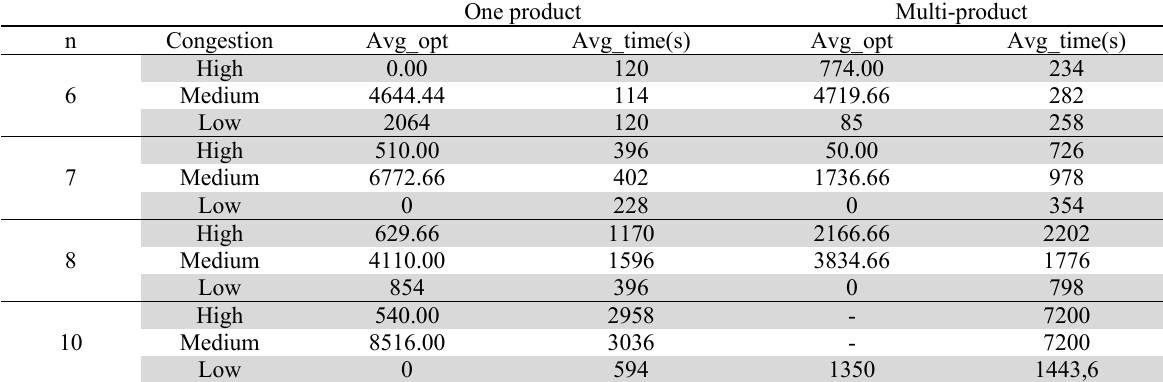
The impact of vessel's congestion on the MIP model One product Multi-product